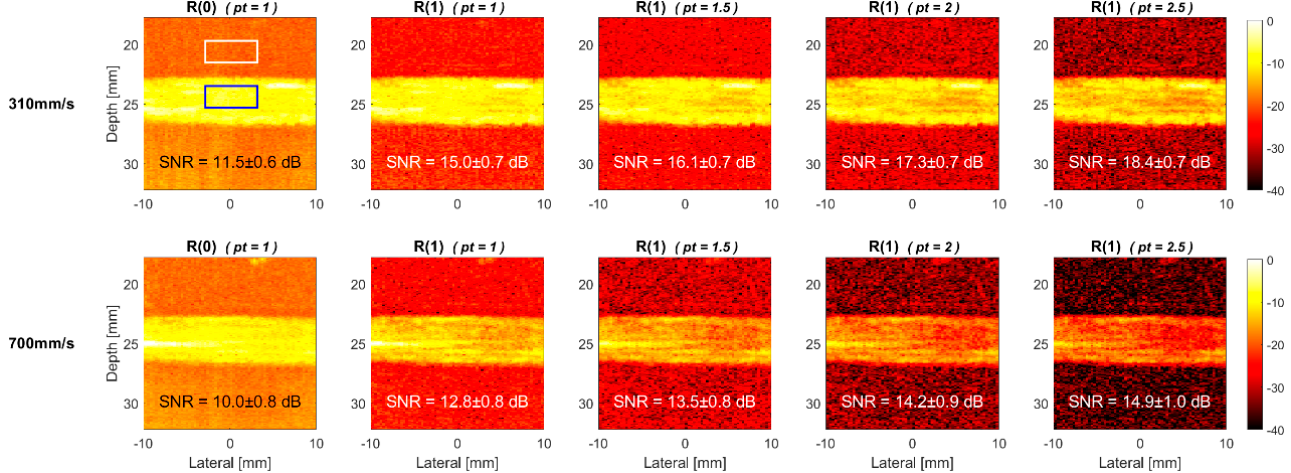
Figure 11. Experimental TMAS power Doppler images of cross-view flow phantom for R(1) images with the pt values of 1.0, 1.5, 2.0 and 2.5, respectively from left to right. R(0) image is also provided as a reference. The flow velocity is 310 mm/s ( upper ) and 700 mm/s ( lower ). The inclined angle of the flow vessel is 0°.